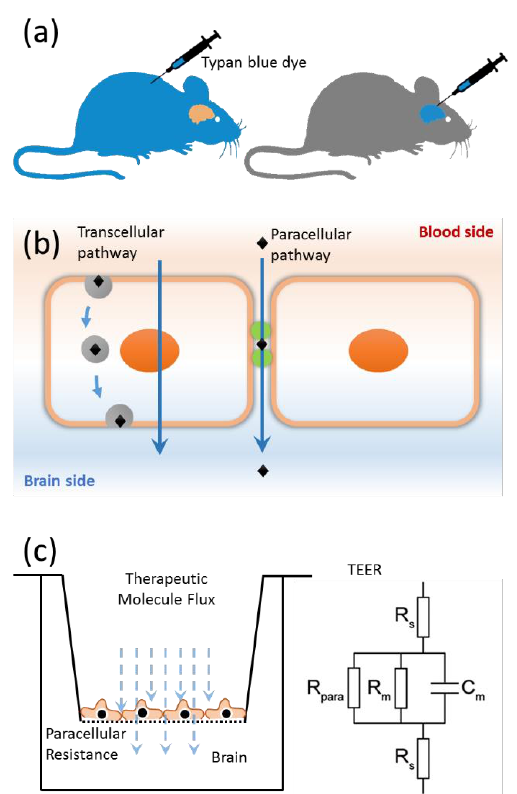
Figure 1. The blood–brain barrier. ( a ) Discovery of the blood–brain barrier (BBB), ( b ) pathways of molecular transport across the neurovascular endothelial barrier: transcellular (arrow through the cell) and paracellular (arrow through space between the two cells) and ( c ) in vitro characterization of the paracellular barrier strength of movement of therapeutic molecules (downward arrows) using transepithelial electric resistance (TEER)